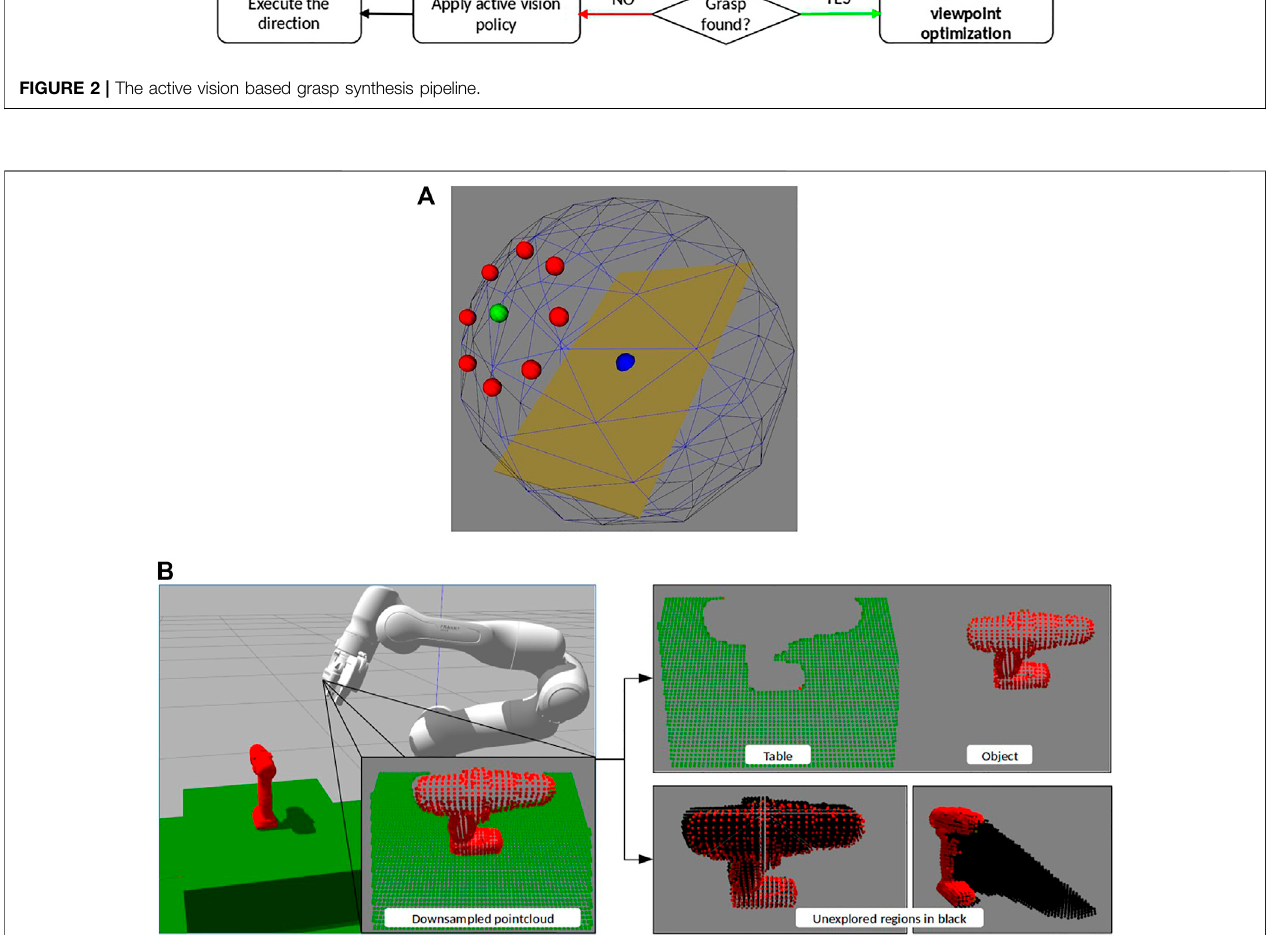
FIGURE 3 | (A) Viewsphere and its next steps with parameters v r (cid:1) 0.4 m, v s (cid:1) 20 ° , and v d (cid:1) 8. The blue sphere is the expected position of the object, the green sphere the current camera position and red one the next steps it can take (B) Example with power drill as object showing the processed pointclouds. Left: Environment as seen by the camera, top-right: Extracted object and table, bottom-right: The unexplored regions of the environment.